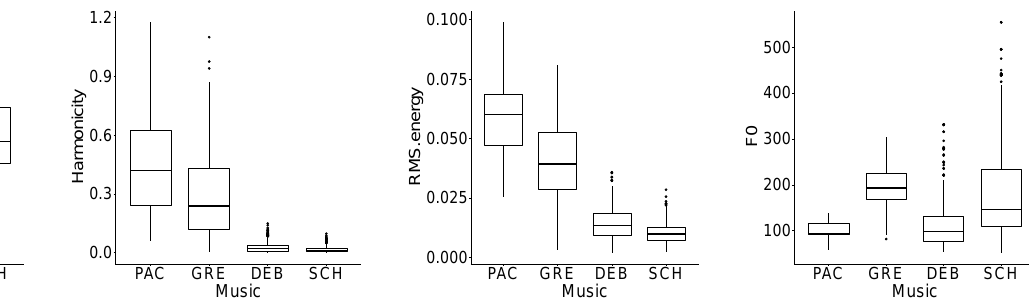
Figure 3. Representation of the musical samples ( x -axis): Pachelbel (PAC), Gregorian (GRE), Debussy (DEB), and Schönberg (SCH); for the acoustic features ( y -axis): sharpness, harmonicity, RMS energy, and F0; from left to right, respectively. First quartile, second quartile, median, third quartile, fourth quartile, and outliers (from bottom to top) are indicated by the box